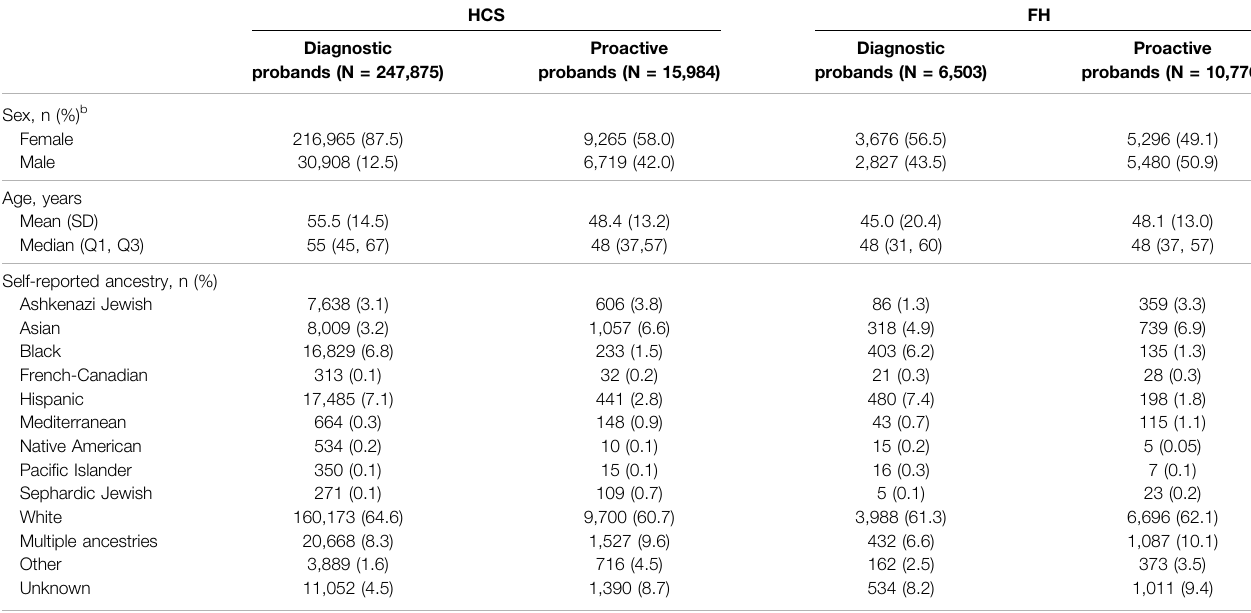
TABLE 1 | Demographic information of probands by clinical area a